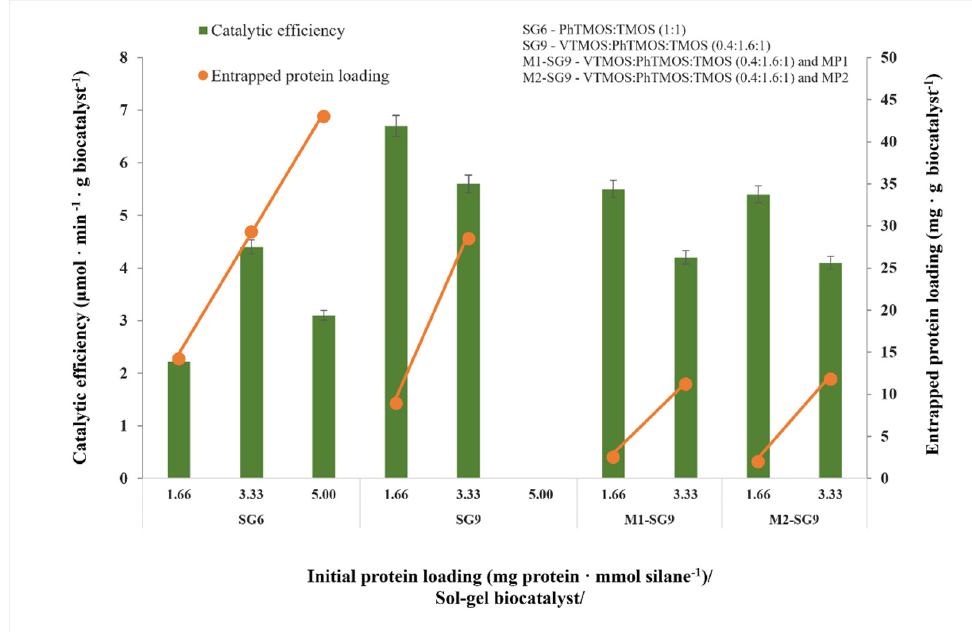
Figure 2. Catalytic properties of immobilized Cellic CTec2 cellulase which was obtained by its entrapment in sol–gel and magnetic sol–gel at different enzyme loadings.